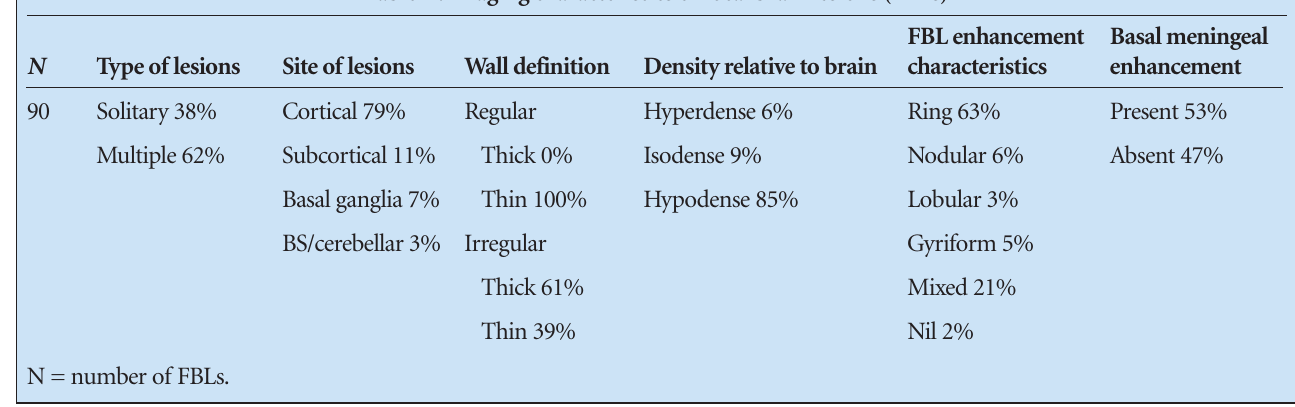
Table II.Imaging characteristics of focal brain lesions